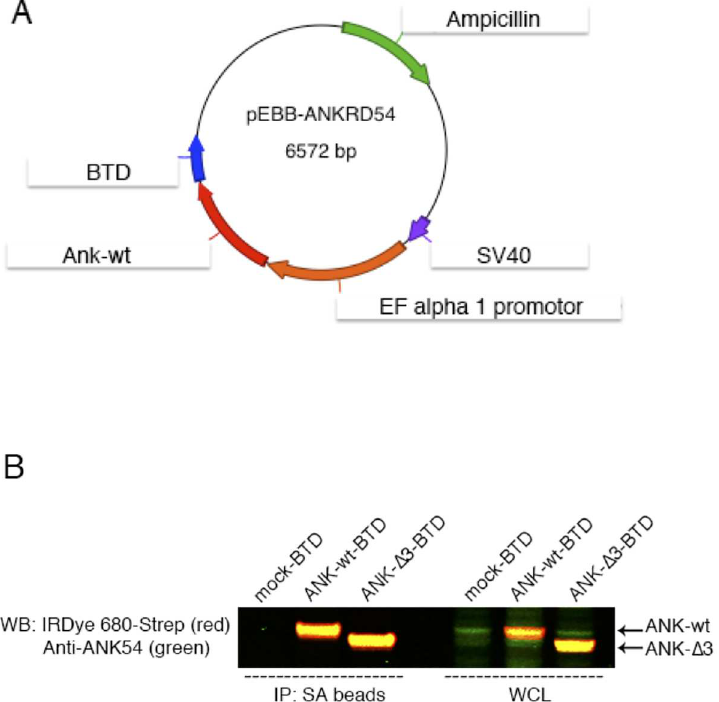
Fig 1. Strategy for protein-analysis and vector validation (A) Schematic representation of the pEBB vector containing biotinylationtarget-domain (BTD) and (B) Simultaneous two-colortarget analysisof ANKRD54 wt and Δ 3 mutant in Cos7 cells. The first three lanes (from left side of the blot) represent immunoprecipitation (IP) with streptavidin (SA) beadsand the last three lanes show wholecell lysate (WCL). Anti-ANKRD54 (green) primary antibody recognizes the C-terminus of the protein and anti-IRDye 680-Streptavidin(red) recognizes the BTD domain.